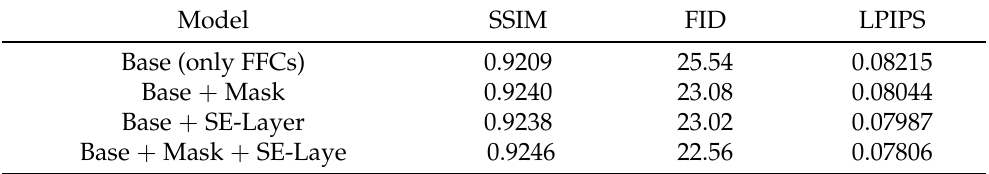
Table 5. Results of experiments on input with a resolution of 256 × 256.